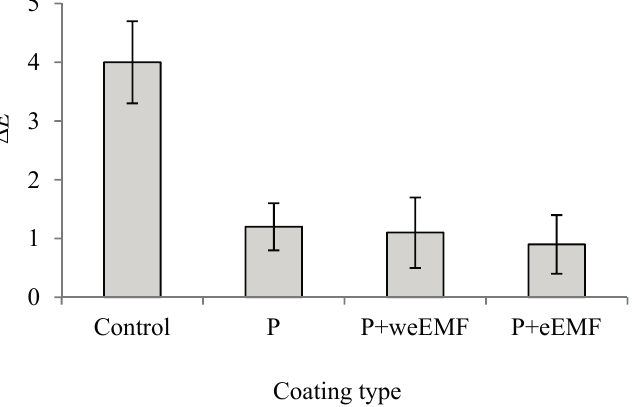
Figure 4. Changes in the color ( Δ E ) of uncoated (Control) and coated peppers after 30 days of cold storage at 6 °C. Red sweet peppers coated with pullulan coating (P), pullulan coating containing water-ethanol meadowsweet flower extract (P + weEMF) or pullulan coating containing ethanol meadowsweet flower extract (P + eEMF). Values are mean ±